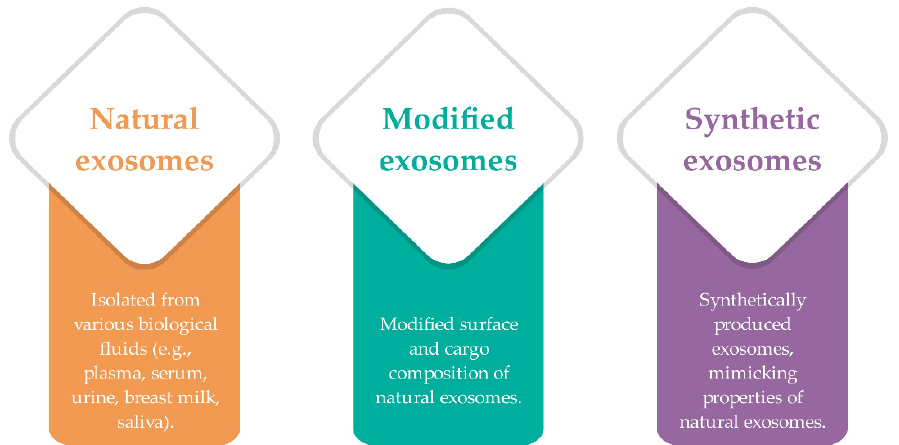
Figure 2. Schematic representation of exosomes classification according to their origin—natural (iso- lated from various biological fluids), modified (natural produced and modified for specific pur- poses), and synthetic exosomes (they mimic properties of natural exosomes; summarized from